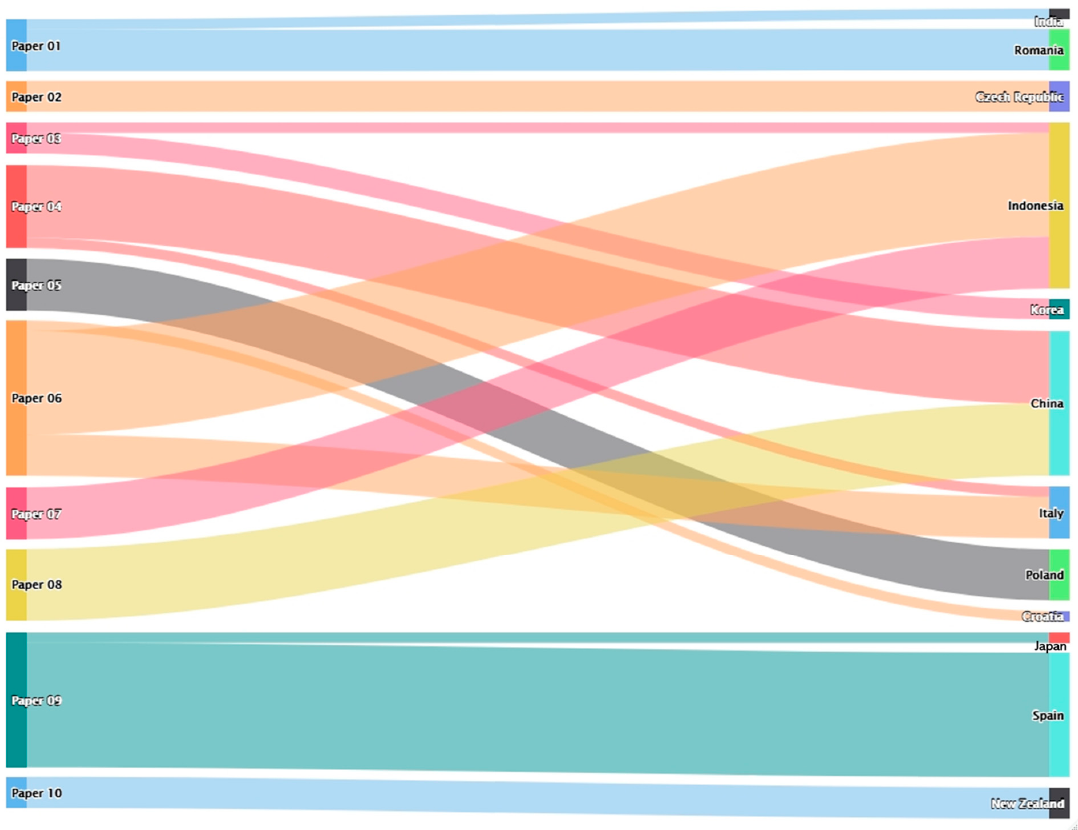
Figure 2. Authors’ affiliation(s) and country (or countries) (right) by paper, with references (left). Data source: